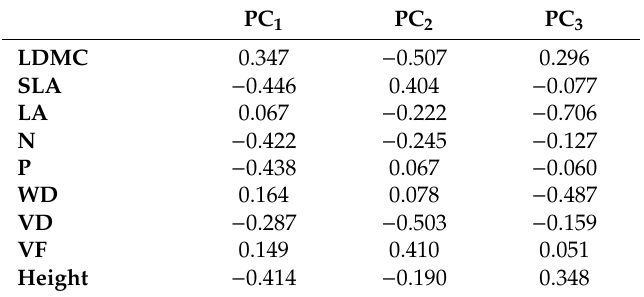
Table A1. Variable Scores for the Principal Components Analysis (PCA).